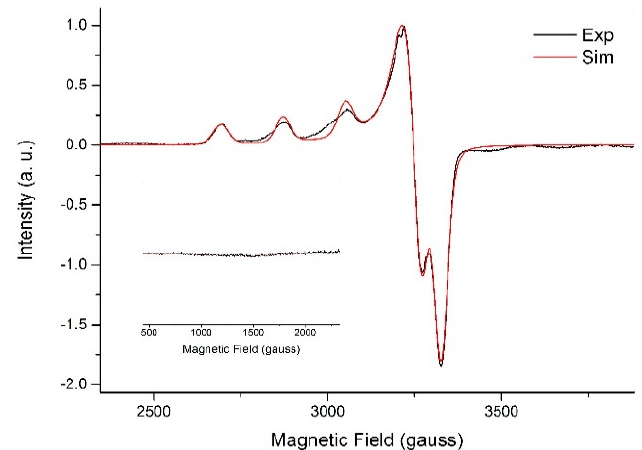
Figure 4. X-band EPR spectra recorded for 1 in frozen H 2 O / glycerol 9:1 (3.0 mmol L − 1 ) solution at 77 K with amplification (inset) evidencing the lack of a half-field transition. Experimental spectrum in black and simulated spectrum in red.